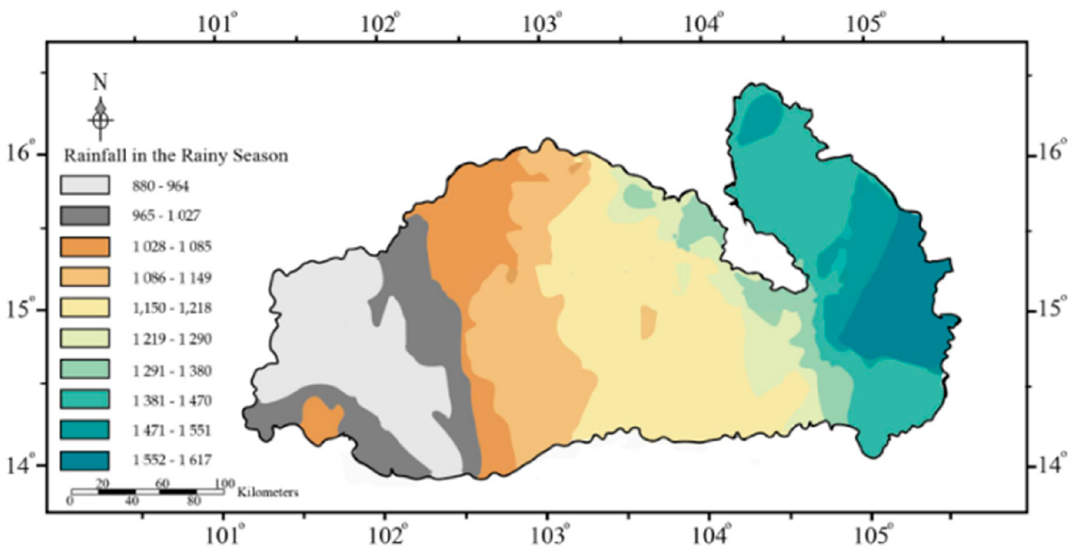
Figure 6. Spatial patterns of annual precipitation in the wet season in the Mun River Basin.